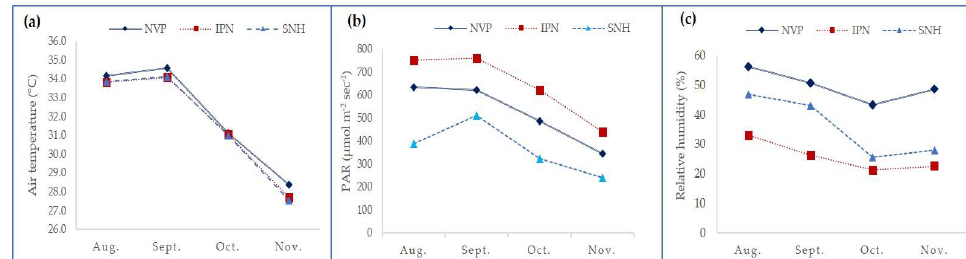
Figure 1. ( a ) Air temperature, ( b ) PAR and ( c ) relative humidity inside different protected structures. Table 1. Grafted seedling cost in INR (INR = 0.013 USD) of cucumber used in the experiment. Grafted Seedling Cost (INR Plant − 1 ) Particulars ‘Nefer’ ‘Terminator’ (Single Fruiting) (Multiple